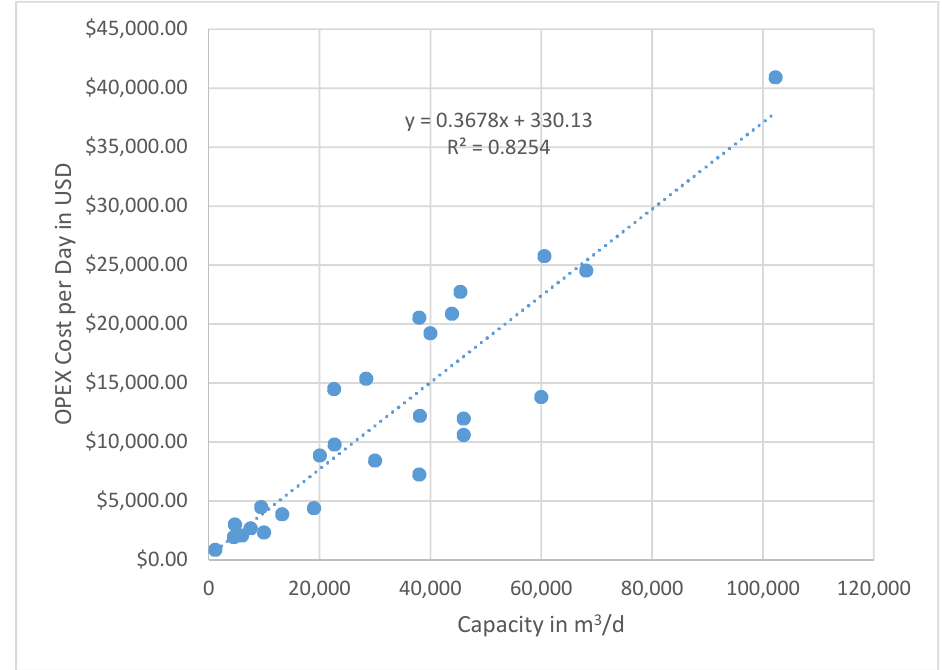
Figure 10. Plot of capacity versus total OPEX cost/day. Note that this plot shows a better fit to the trend line with a high R 2 value. The equation for the trend line has a slope of less than one-to-one, which is indicative of a lower unit cost with a larger capacity. Therefore, scaling of capacity is an important economic factor. Note that these costs are not corrected for local inflation, which may not directly correlate with increased costs to consumers (e.g., foreign water subsidies).